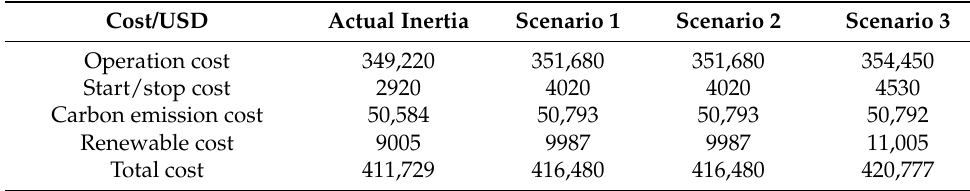
Table 1. Results for day-ahead scheduling costs.